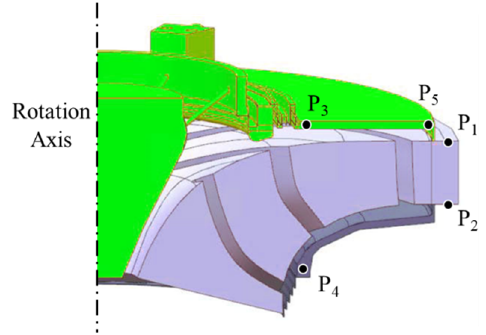
Figure 5. Pressure monitoring point selection.